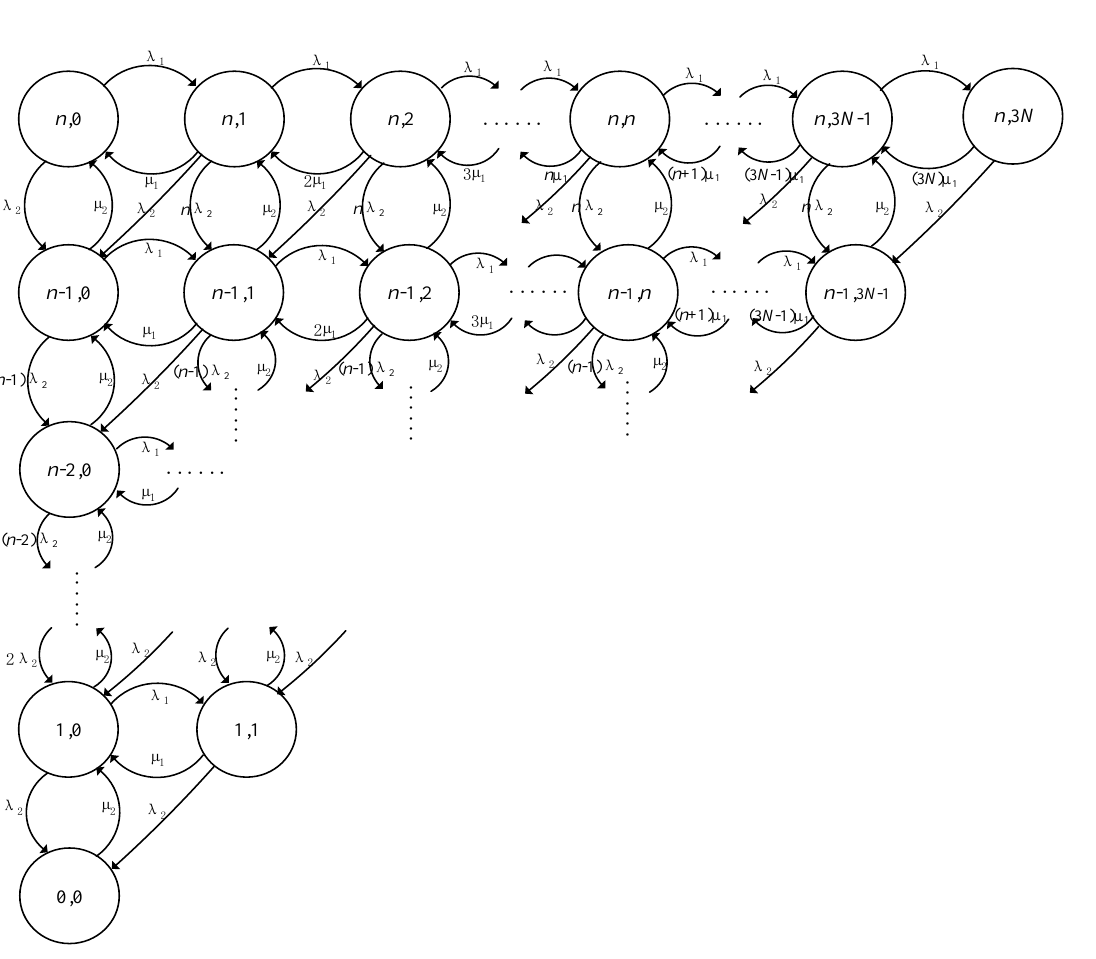
Figure 5. The survivability model of SDN-based V2I networks.